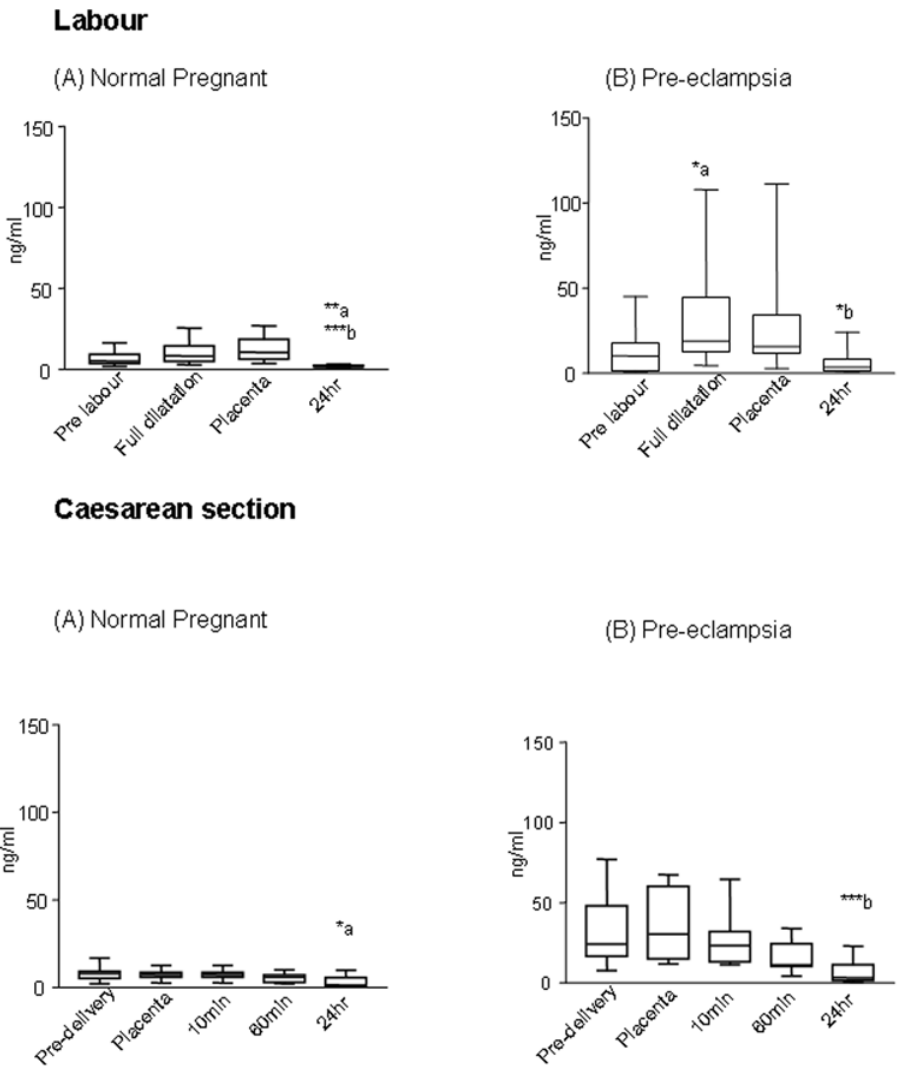
Figure 3. Median and ranges (n=10) for sFlt-1 levels (ng/ml) in maternal plasma during labour (A,B) and Caesarean section (C,D) in normal pregnancy and women with pre-eclampsia. In normal pregnancy labour (A) the levels showed a significant decline by 24 hr (a**p , 0.01-full dilatation vs 24 hr, and b***p , 0.001-placental delivery vs 24 hr). In pre-eclampsia labour (B) a significant increase in sFlt-1 levels was noted (a*p , 0.05, -pre-labour vs full dilatation) and the levels declined post-delivery (b*p , 0.05-full dilatation vs 24 hr). At Caesarean section (C,D) a significant decline in levels of sFlt-1 by 24 hr was noted compared to those at placental delivery (NP a*p , 0.05 and PE b***p , 0.001, placental delivery vs 24